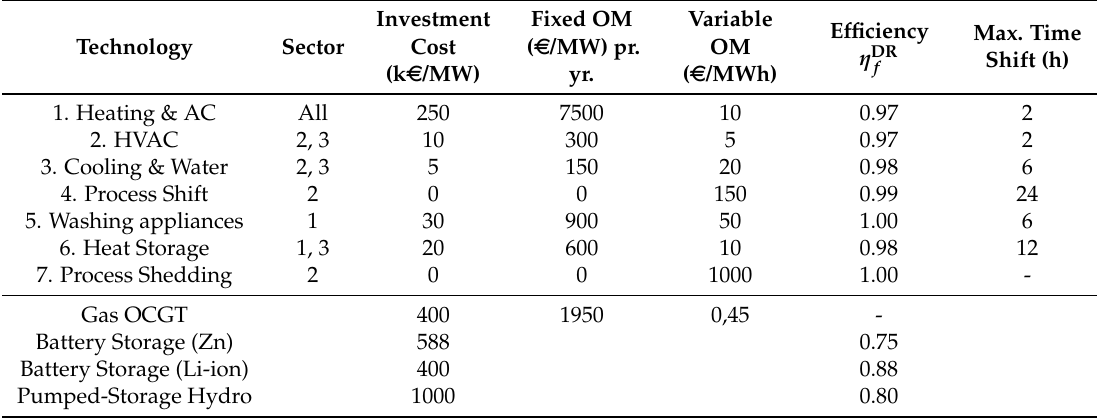
Table A1. DR technology costs for the 7 groups considered in the model and other technology costs for